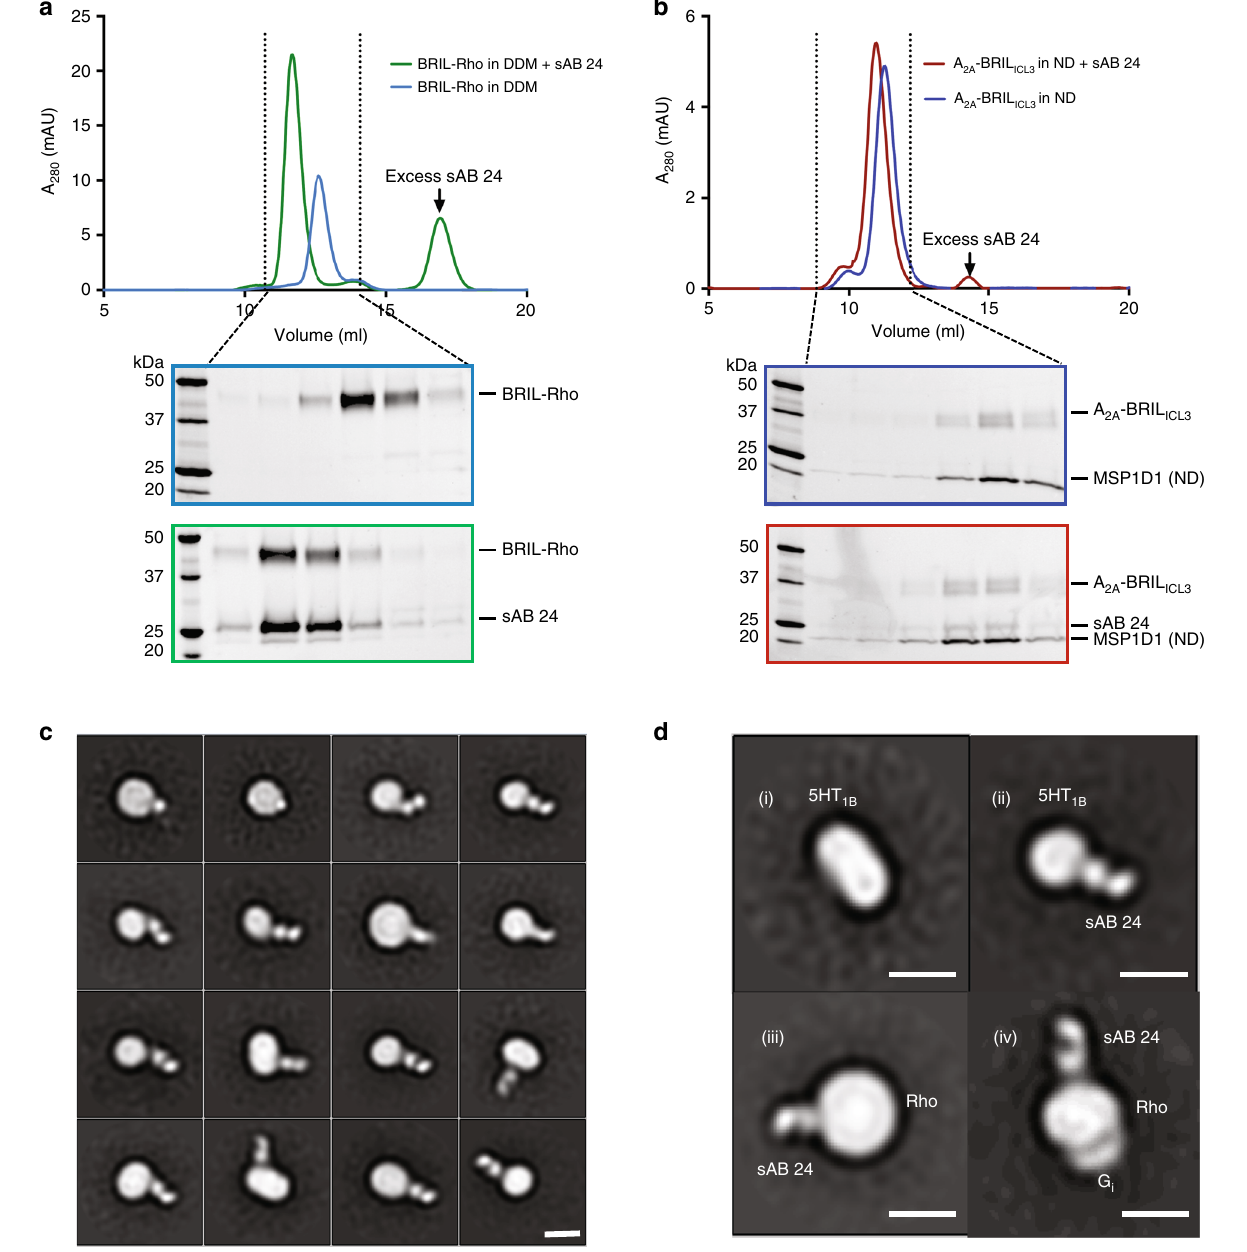
Fig. 2 sAB24 binds to membrane proteins in detergents, amphipols, and nanodiscs. aSEC pro fi les and SDS-PAGE gels of complex formation of sAB24 with a BRIL-Rhodopsin in DDM and b A 2A -BRIL in nanodisc 1D1. c 2D class averages from negative-stain images of sAB24 bound to BRIL-Rhodopsin in amphipol. d 2D class averages of the negative-stain images from: (i) BRIL-fused serotonin receptor (5HT 1B ) without sAB24 and (ii) with sAB24 in nanodisc E3D1, (iii) complex of BRIL-Rhodopsin and sAB24 in DDM (iv) complex of BRIL (N-term)-Rhodopsin bound to trimeric G i and sAB24 in nanodisc E3D1. BRIL is fused to the N-term of Rhodopsin while the 3rd intracellular loop (ICL3) of the adenosine receptor A 2A and serotonin receptor 5HT 1B are replaced by BRIL. Micrograph of 5HT 1B – sAB24 complex is in Supp. Figure 4a. Scale bars in ( c , d ) are 100